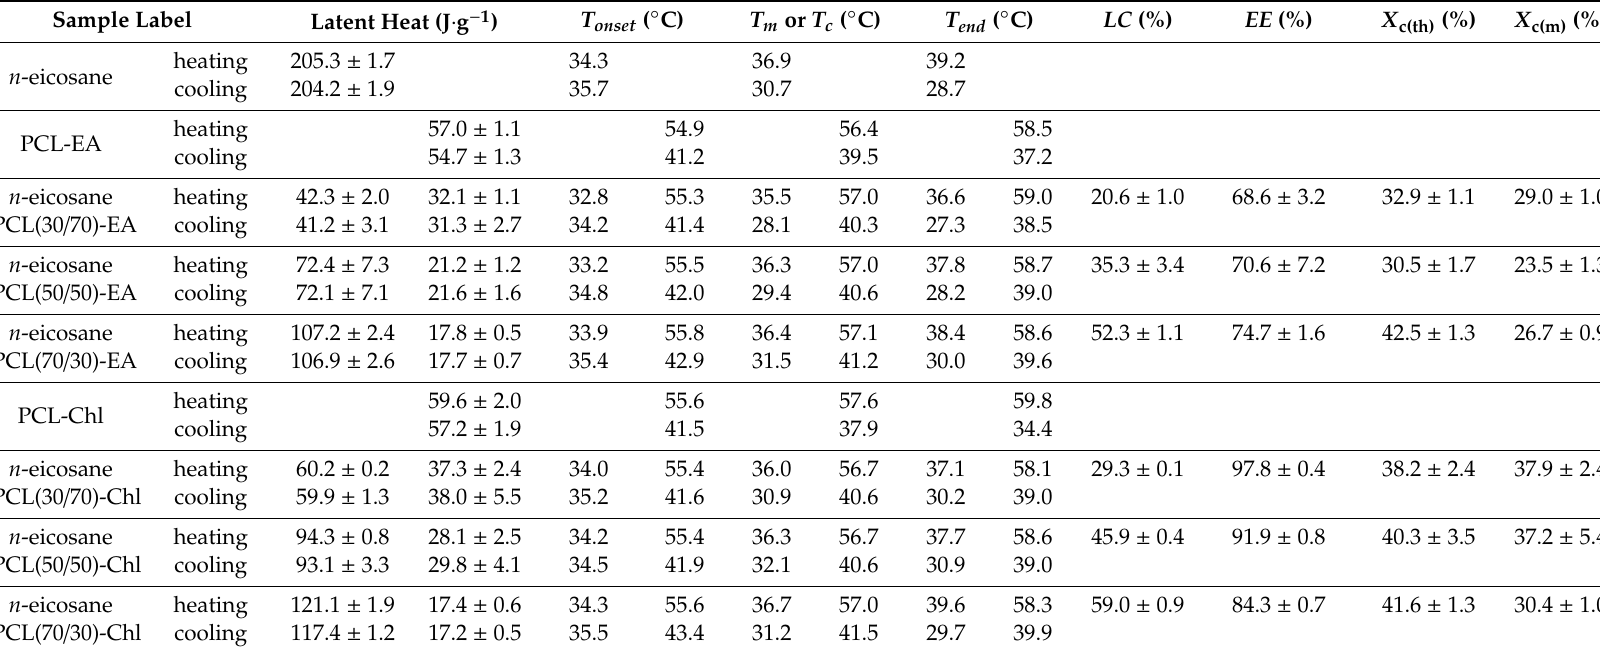
Table 2. Thermal properties of n -eicosane, neat PCL microspheres and a series of n -eicosane / PCL microcapsules obtained from ethyl acetate and chloroform solutions at three weight ratios between n -eicosane and